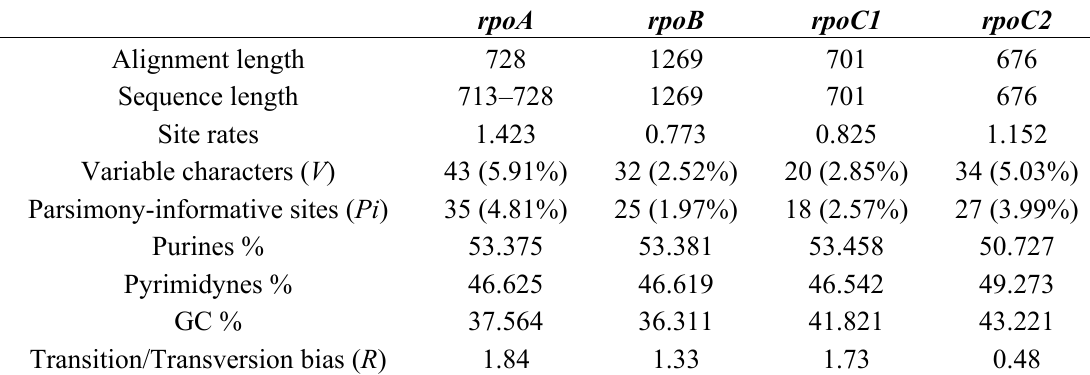
Table 1. Comparison of the analyzed rpo gene